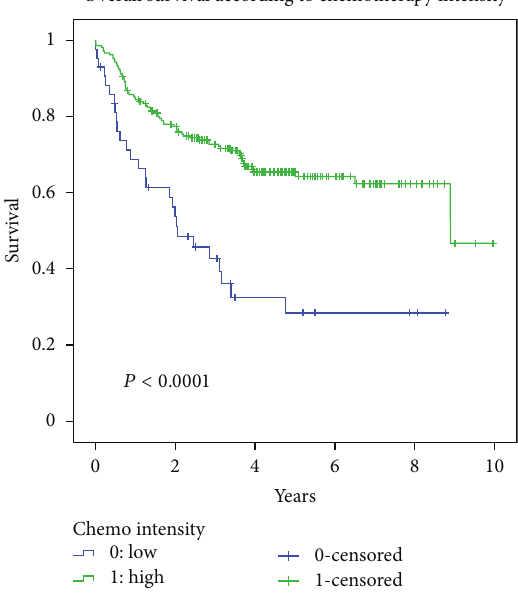
Figure 6: Overall survival according to chemotherapy regimen.